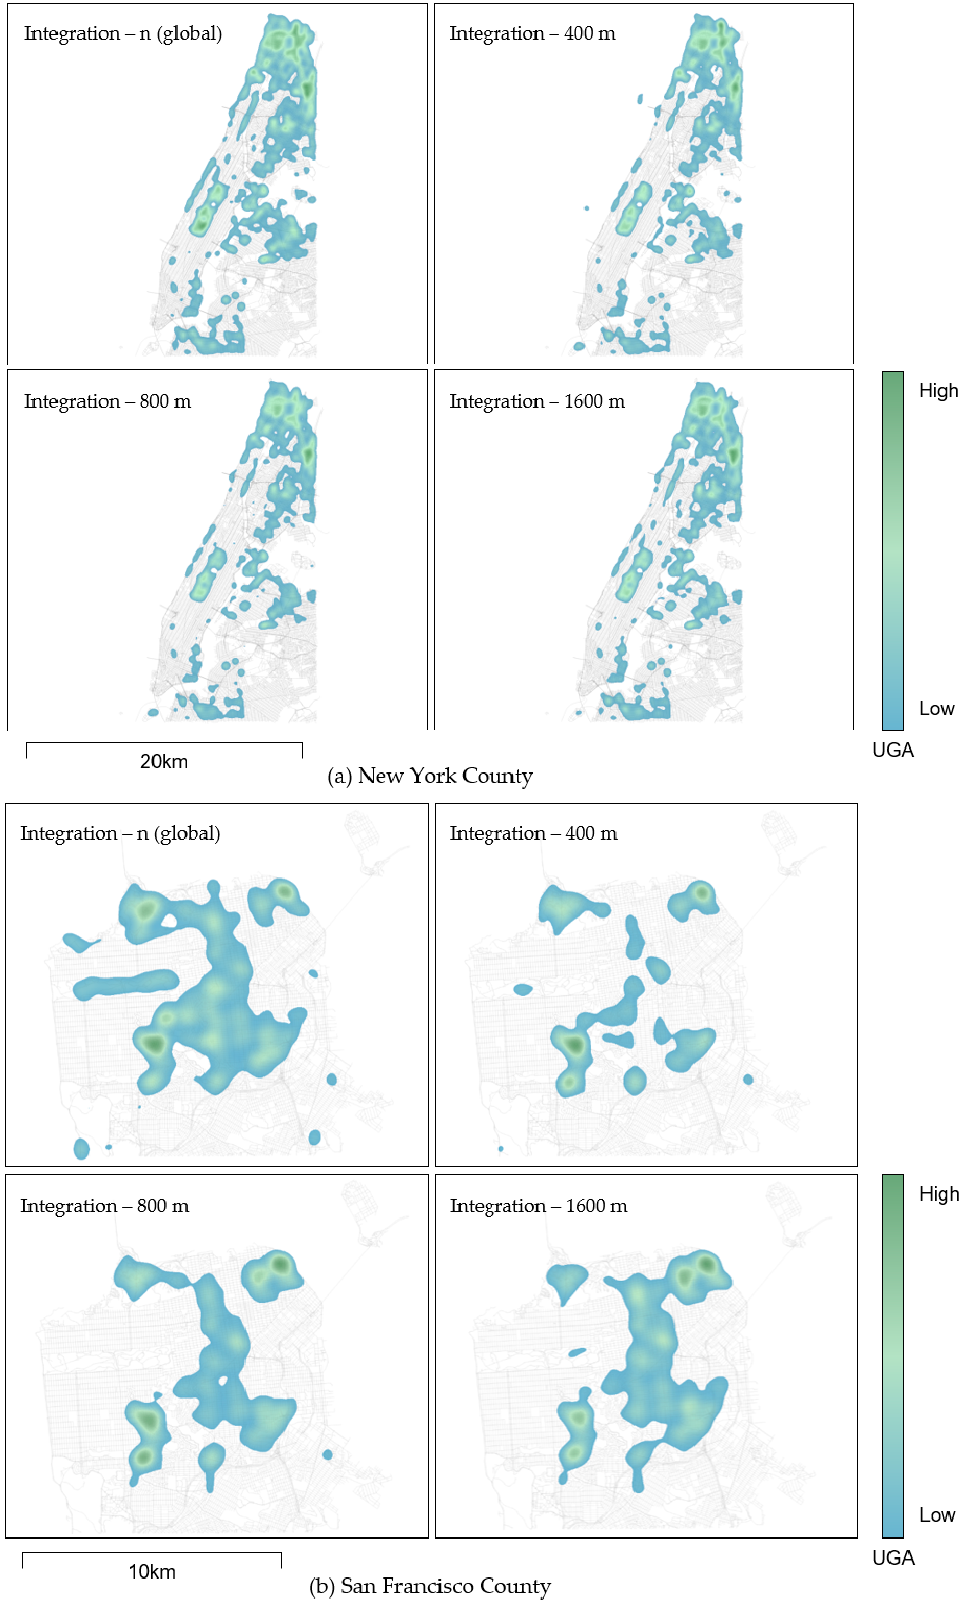
Figure 4. Urban green accessibility distribution with integration index applied as the topological value. (a) New York County (b) San Francisco County. As the integration value measures the total depth (or distance) from each segment to all the other segments within the road network, inner areas that are relatively interpreted as “shallow” normally show high results. Urban green accessibility distribution when integration index was applied for calculation is shown in Figure 4. In Figure 4(a), the results of global and local scale analyses do not show any clear distinction, as the grid-like road structure of New York renders the relative depth of street segments similar in both scales. On the contrary, in Figure 4(b), Golden Gate Park, which appeared with high accessibility values in a global scale, is either slightly or not included in the visualizations of local scale measurements. This implies that parks that occupy larger areas promote access for people from every corner of the city while lesser-known neighborhood parks can better appeal to people within walking distance. Similarly, Lake Merced Park appears in the global and 400 m cases, and disappears in the other two. The contrast between the result with global integration and results with local integration values explains the difficulty in pedestrian access to large parks. Interesting is the slight appearance in both Golden Gate Park and Lake Merced Park in the 400 m case compared to the other two local scale analyses. This indicates the relative ease in accessing a large park by foot particularly when it is located within 5-minute walk. The contrast between UGA distribution and the quantitative interpretation of green spaces with the NDVI result will be further discussed in the following section. 5. Discussion: Analysis and Effect of Urban Green Accessibility This study successfully develops an urban green accessibility (UGA) model and verifies its effectiveness in measuring accessibility to green spaces through cases of New York, NY and San Francisco, CA. Accessibility is comprehensively measured by adding two more variables other than